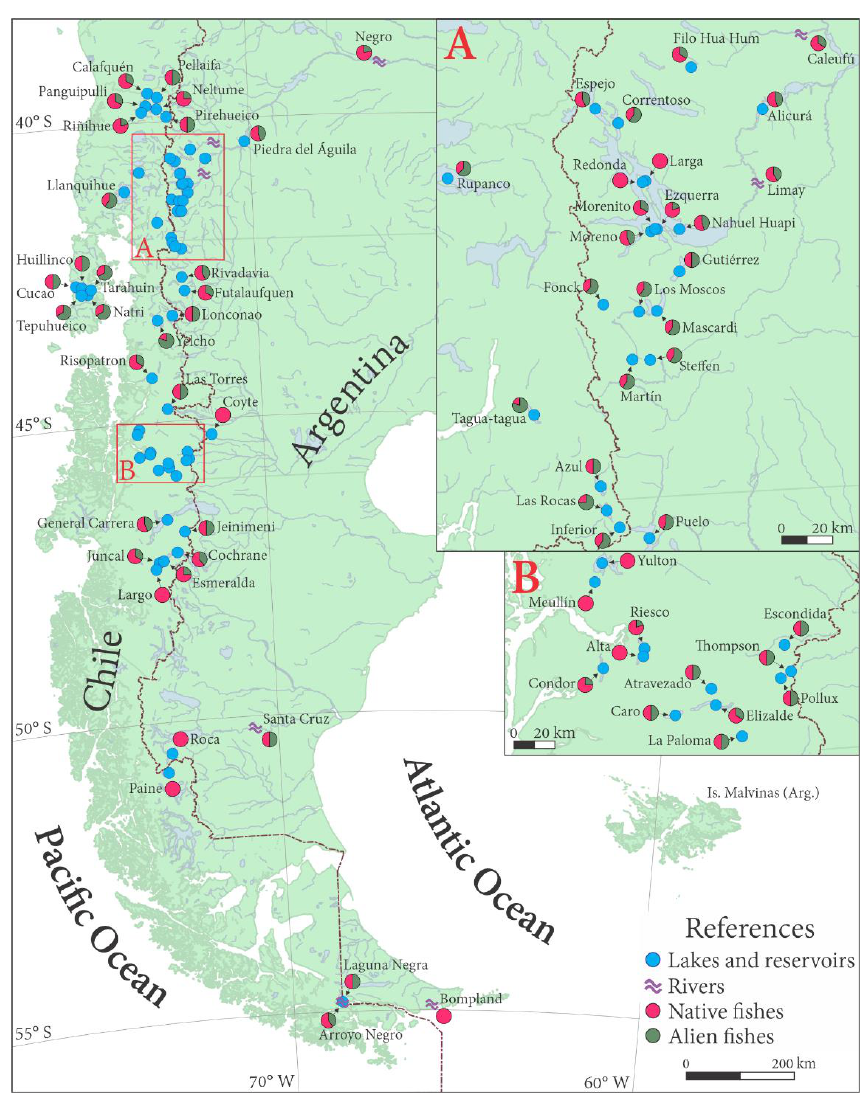
Figure 1. Lakes, reservoirs and rivers with the presence of galaxiids and alien fishes. Focus is on the Nahuel Huapi National Park (A, Argentina) and Aysén Region (B, Chile). The pie charts indicate the proportion of native and alien fishes. The predator-associated morphology was observed [27] in G. platei individuals collected from nine deep Andean lakes and one shallow lake on the Patagonian plateau (Espejo, Gutiérrez, Moreno, Coyte, Fonck, Los Moscos, Martin, Mascardi, Steffen and Rivadavia, Table S1). The length of the caudal fin was negatively correlated with the incidence of piscivory in each lake. As such, G. platei individuals from lakes with high piscivory rates were characterized by relatively short caudal fins, and those from lakes with low piscivory were characterized by long caudal fins. The population from lake Espejo (Table S1), with an intermediate piscivory level, was inhabited by individuals with both long and short caudal fins. Furthermore, the morphological variation within this lake was explained